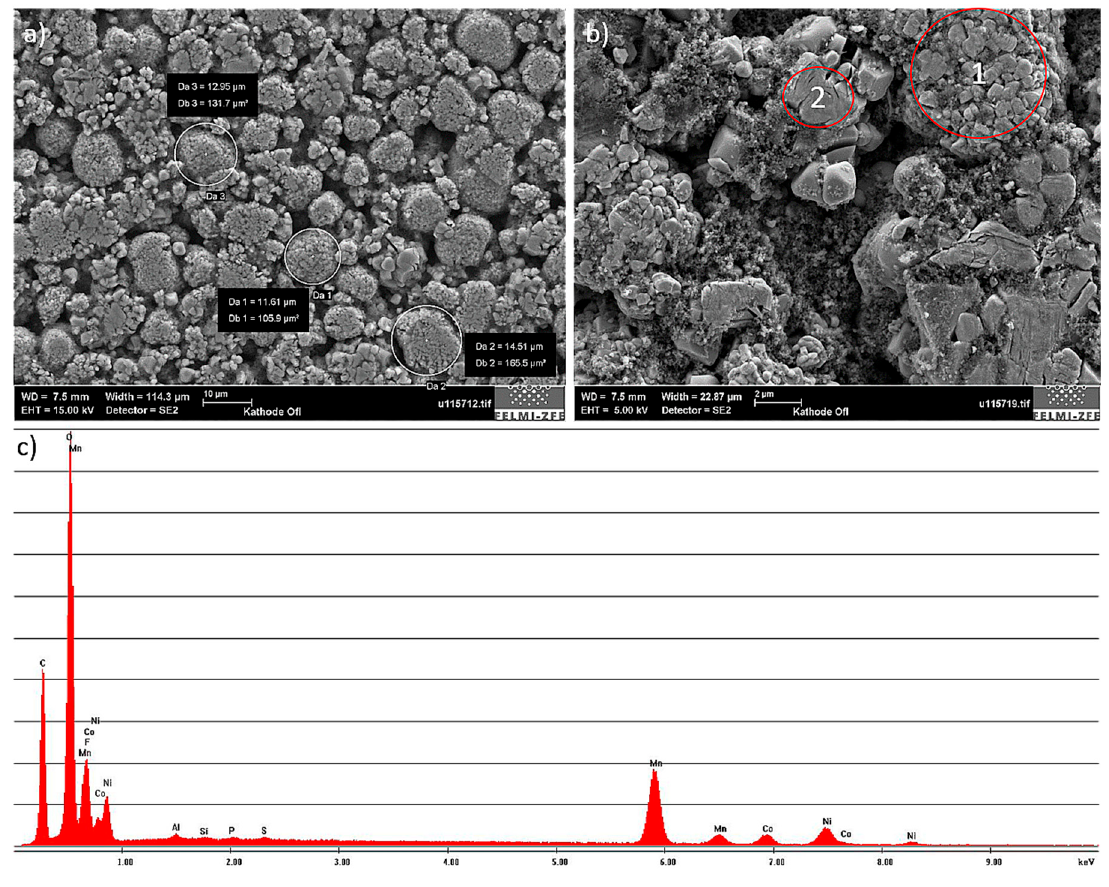
Figure 10. Surface imaging and structure identification of the battery cathode. ( a ) The cathode granular surface structure, whereby the largest grains were about 15 µm. ( b ) The two types of structures identified on the cathode surface; here, “1” marks the LiNiMnCoO 2 (NMC) compound, whereas “2” marks the formed manganese oxide (LMO). ( c ) Chemical elements determined on the anode surface by EDXS.